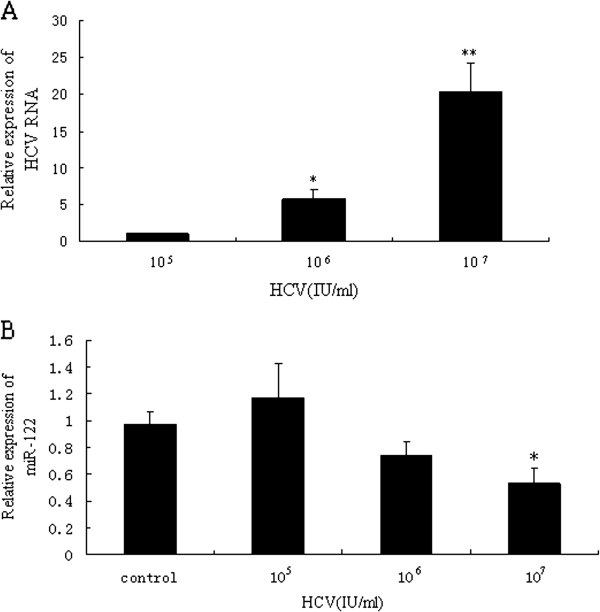
Expressions of HCV RNA and miR-122 in Huh7.5.1 cells after infection with different levels of HCV. (A) Intracellular expressions of HCV RNA in Huh7.5.1 cells infected with different levels of HCV were assayed, using 105 IU/ml group as control group. (B) Intracellular expressions of miR-122 in Huh7.5.1 cells infected with different levels of HCV were assayed, using mock group as control group. The data were presented as means ± SD of three independent experiments. *P < 0.05, **P < 0.01 vs. control group.